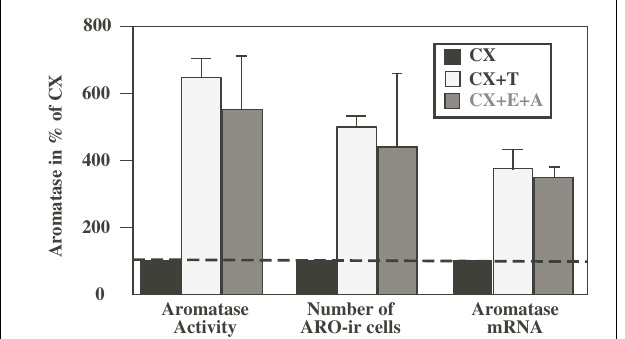
FIGURE 1 | Effects of the treatment of castrated (CX) male quail with testosterone (T) or with estrogens (E) in combination with non-aromatizable androgens (A) on aromatase activity (AA), on the number of aromatase-immunoreactive (ARO-ir) cells and on the concentration of the aromatase mRNA in the quail preoptic area. All data are expressed as percent of values obtained in CX birds to allow direct comparisons. Redrawn from data in Schumacher and Balthazart (1986), Schumacher et al. (1987), Harada et al. (1992, 1993), Balthazart et al.